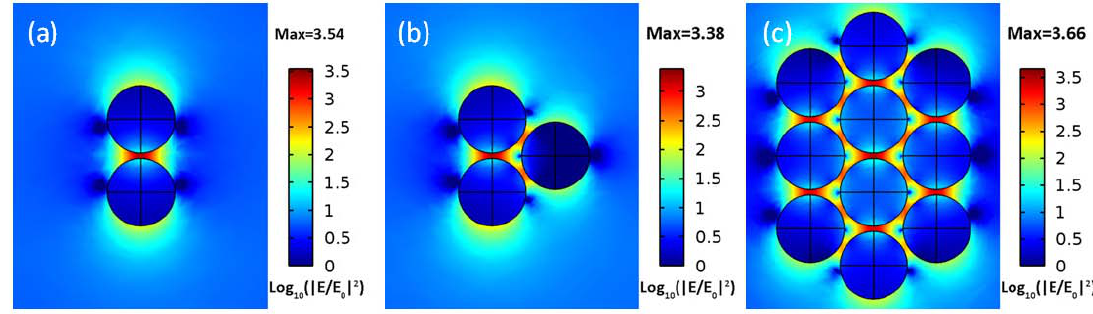
Figure 5. Electric field distribution (top view) of ( a ) a Ag dimer, ( b ) a Ag trimer